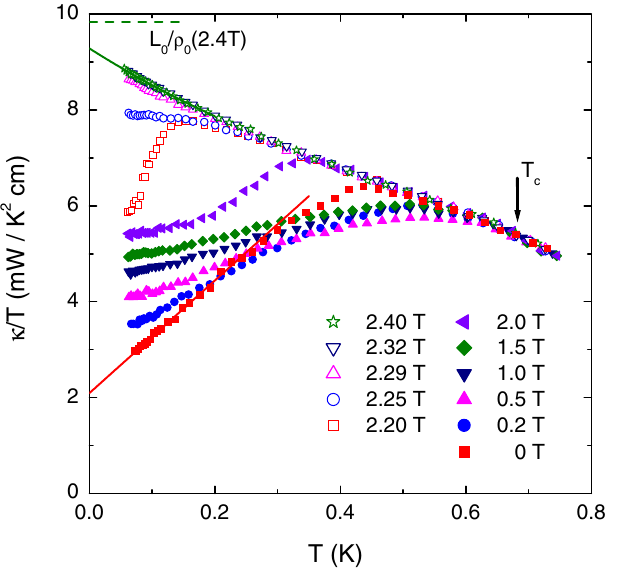
Fig. 4. For comparison, similar data of the clean s -wave